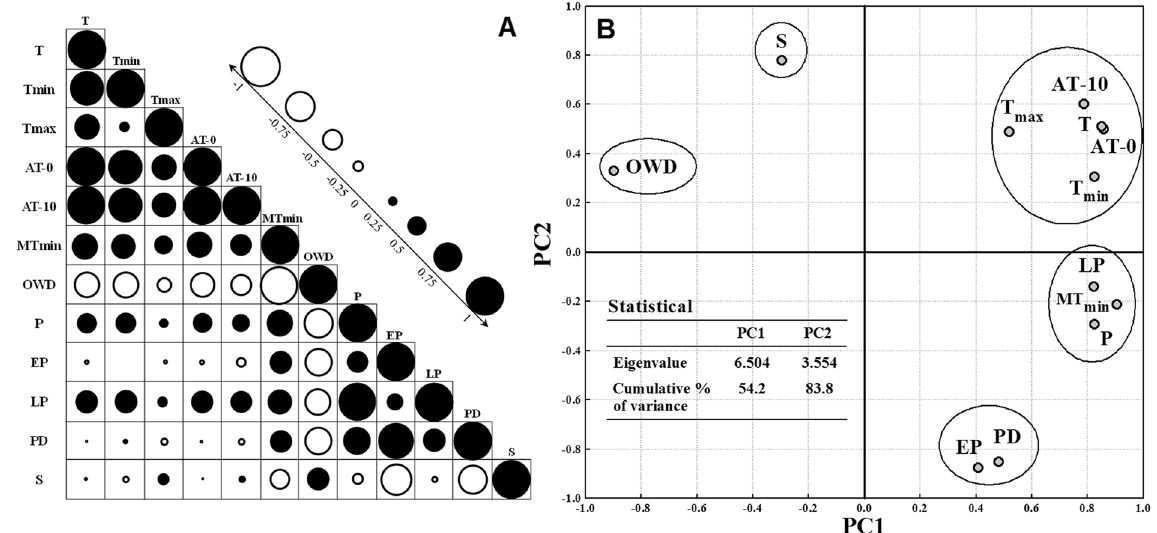
Figure 1. Correlation coefficient matrix ( A ) of the meteorological factors and loading distribution ( B ) in an extracted principal component analysis. T mean temperature, T min mean daily minimum temperature, T max mean daily maximum temperature, AT-0 mean ≥ 0 °C accumulated temperature, AT-10 mean ≥ 10 °C accumulated temperature, MT min mean minimum mean monthly temperature, OWD mean overwintering days, P mean precipitation, EP mean precipitation at an earlier stage, LP mean precipitation at a later stage, PD mean precipitation days, S mean sunshine